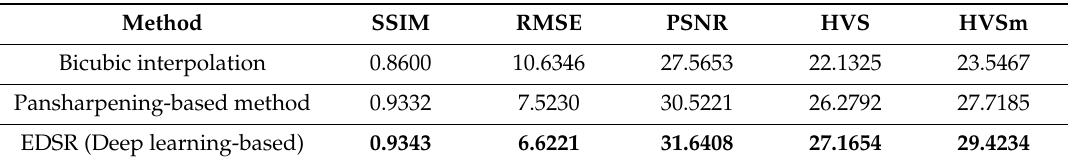
Figure 10. Foreground image section of the motorcycle image. Table 4. Image quality measures for the foreground image part of the enhanced left camera images. Bold format indicates the method providing better results.